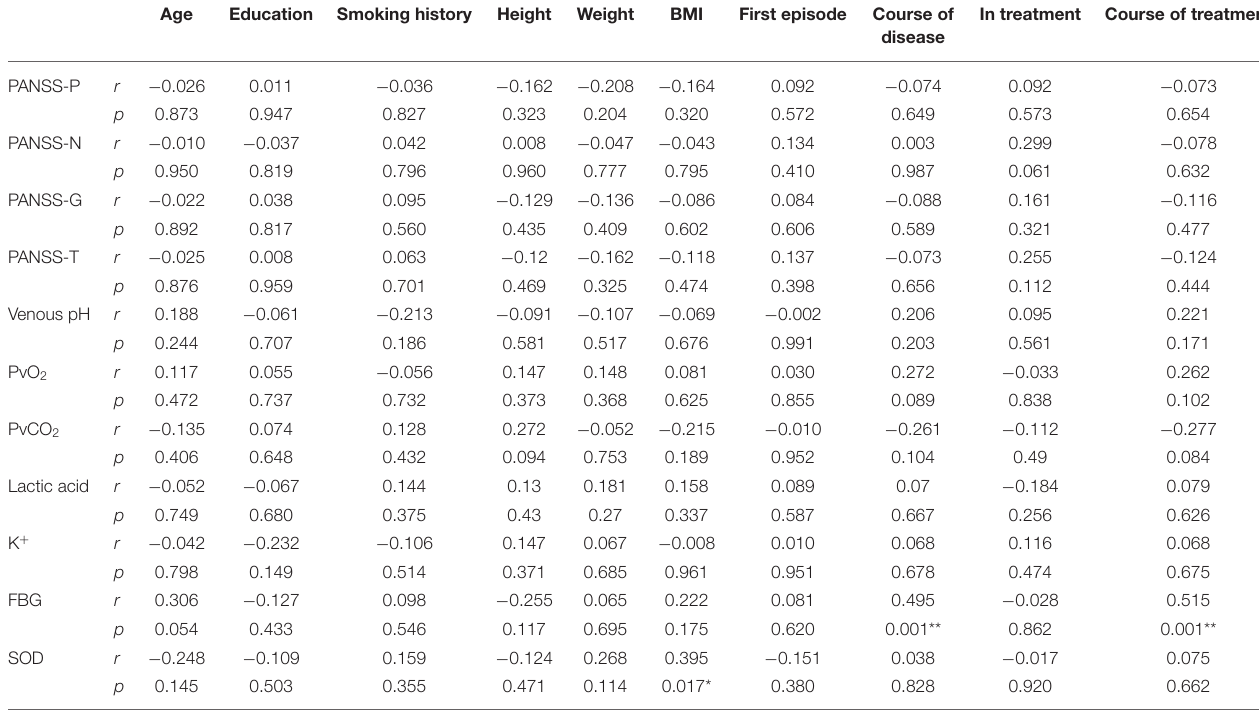
TABLE 3 | Correlation analysis between the general situation and the effect indicators in the SCH group. Age Education Smoking history Height Weight BMI First episode Course of